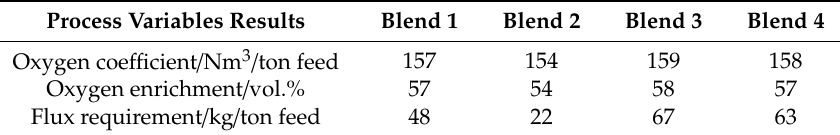
Table 12. Process variables: Oxygen coe ffi cient and flux requirement of each blend. Process Variables